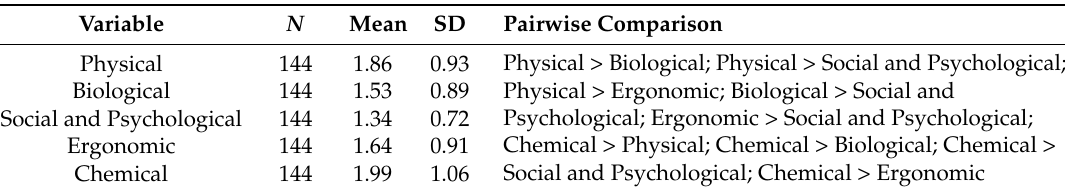
Table 3. Repeated measures one-way analysis of variance.